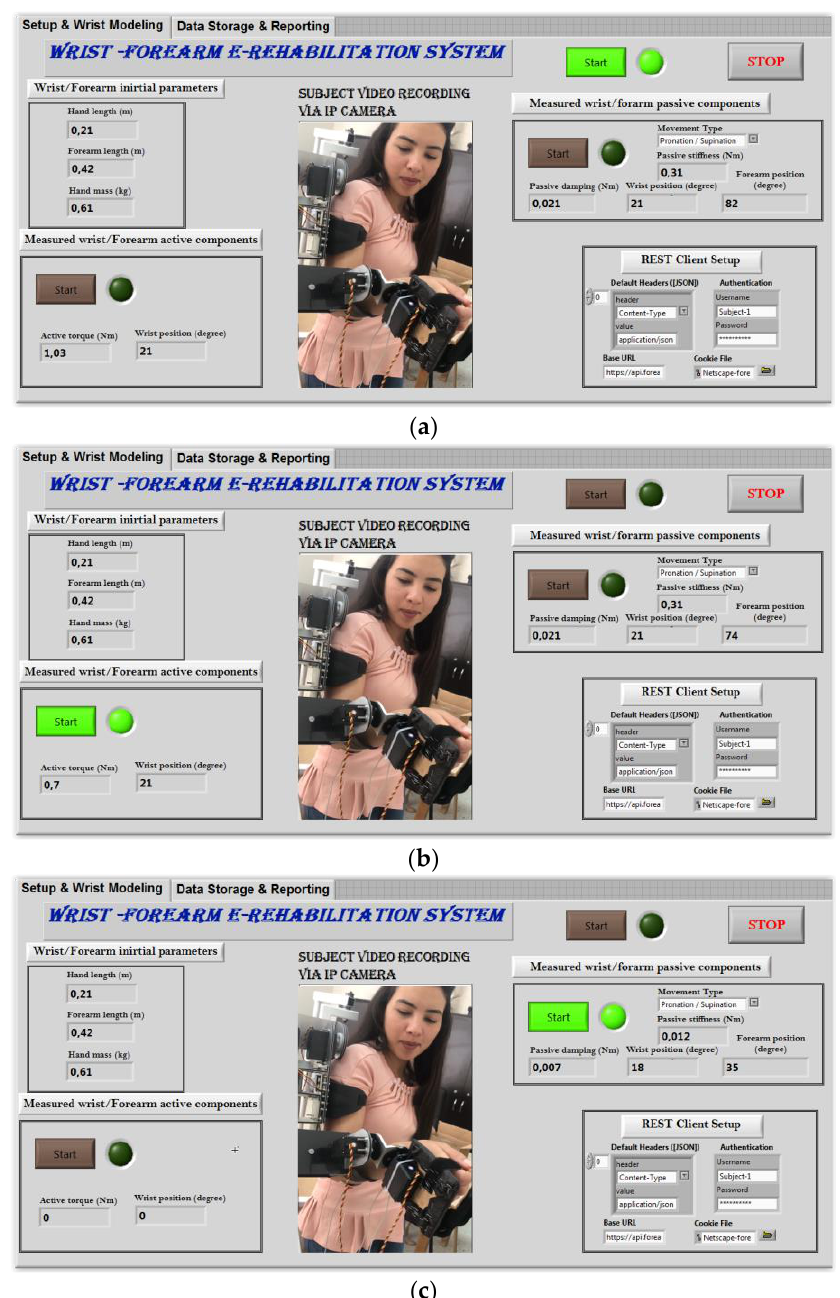
Figure 13. Setup sequences: ( a ) measuring passive wrist components; ( b ) measuring wrist active components; ( c ) continuous exercises.